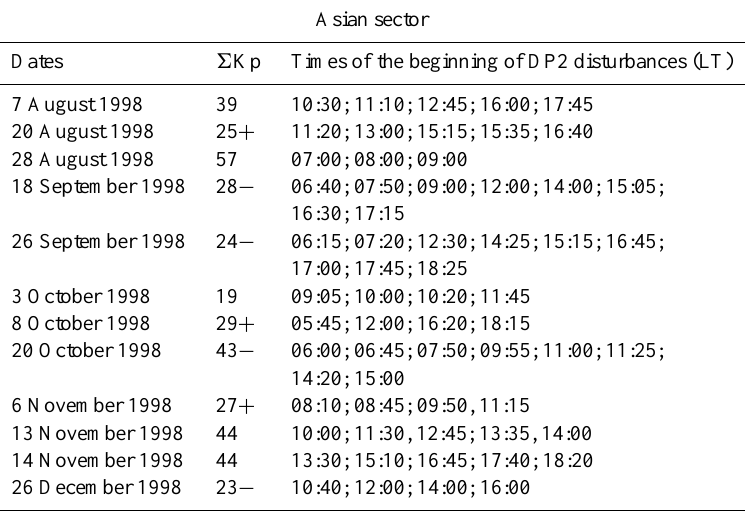
Dates 6 Kp Times of the beginning of DP2 disturbances